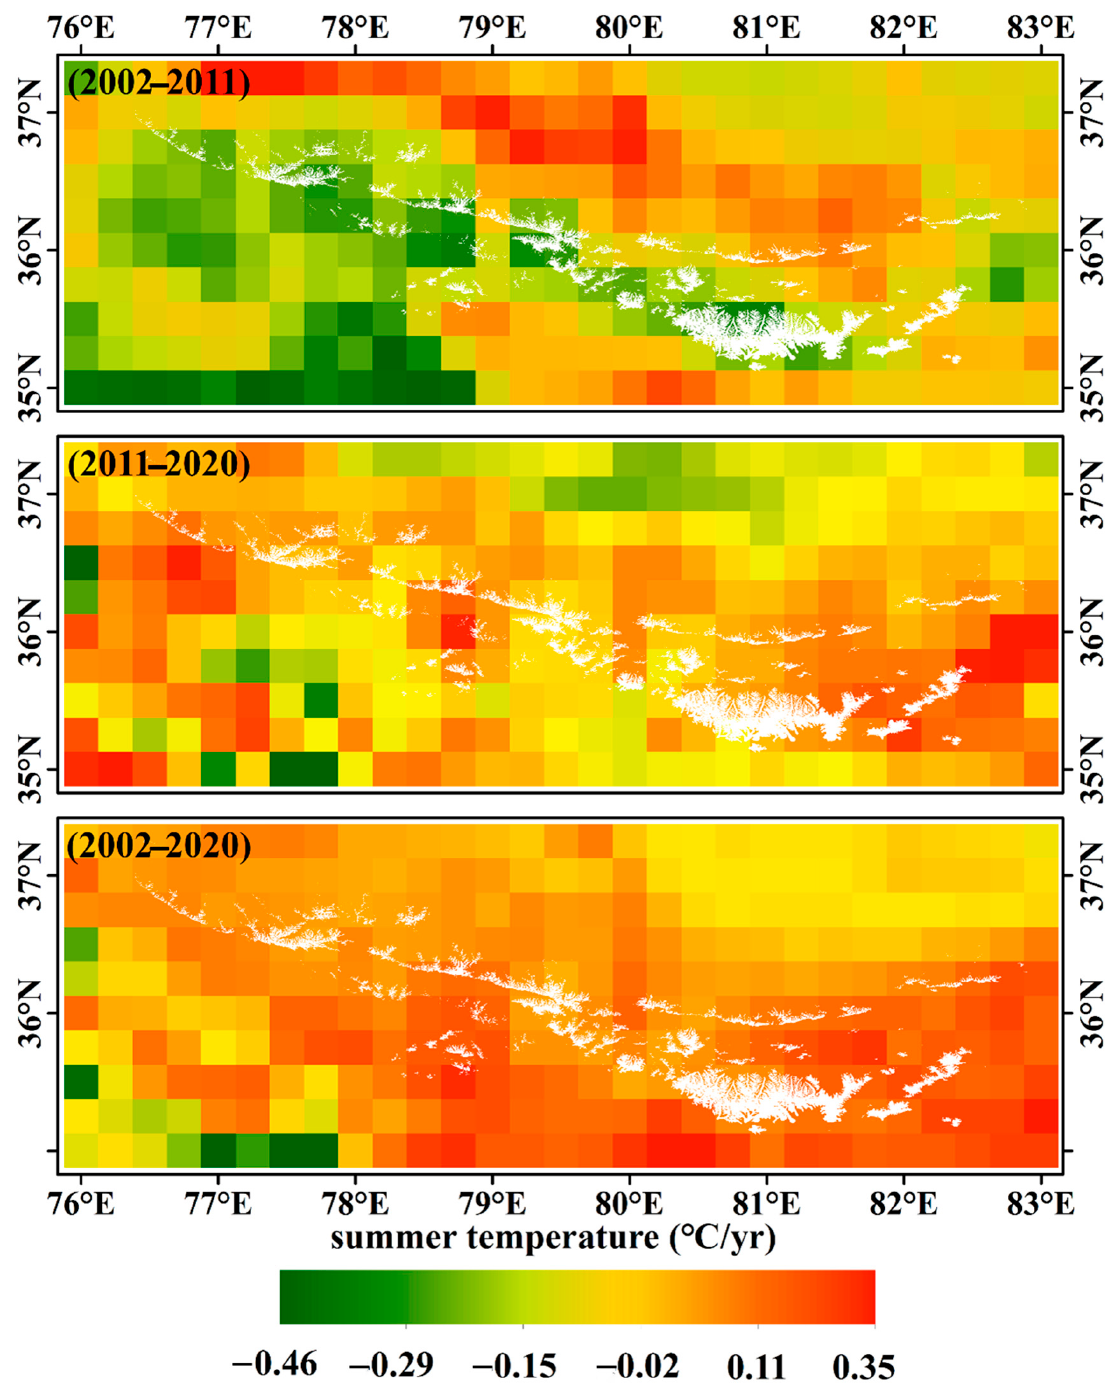
Figure 6. Annual JJA skin temperature trends in WK for 2002–2011, 2011–2020, and 2002–2020, derived from